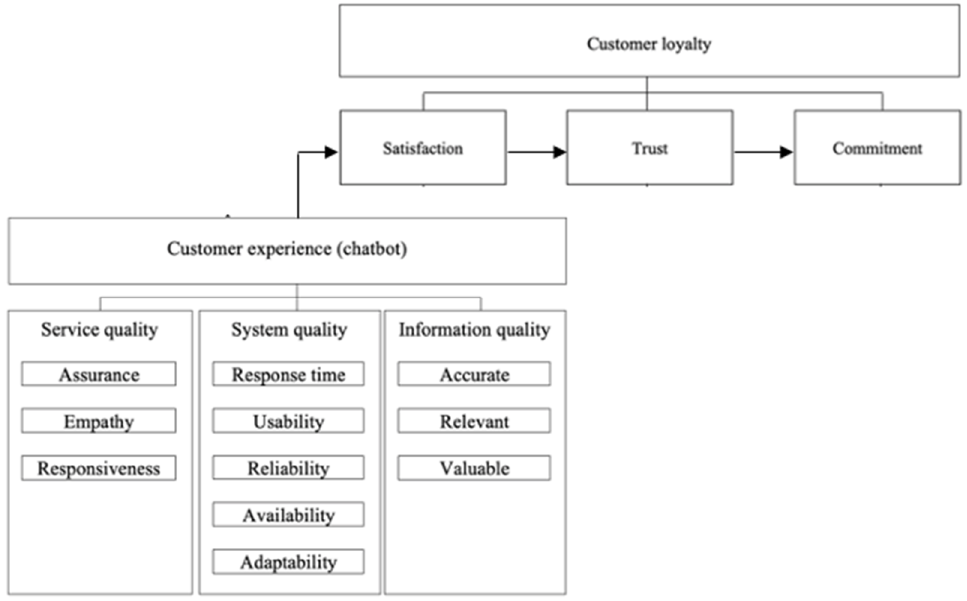
Figure 7. Customer experience and customer loyalty.